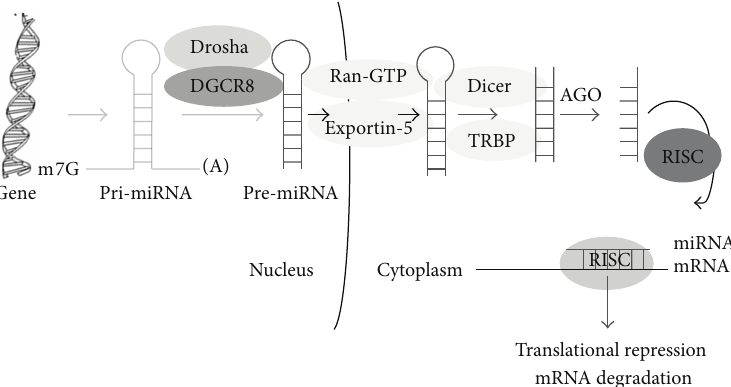
Figure 1: Biogenesis of miRNA. miRNAs are transcribed into pri-miRNA and are capped and polyadenylated. This pri-miRNA is processed by Drosha and DGCR8 into pre-miRNA, which by Ran-GTP and Exportin-5 are transported into the cytoplasm and further processed by Dicer. The miRNA dissociates and with help of RISC gets involved in gene silencing by translation repression or degradation of target mRNA.